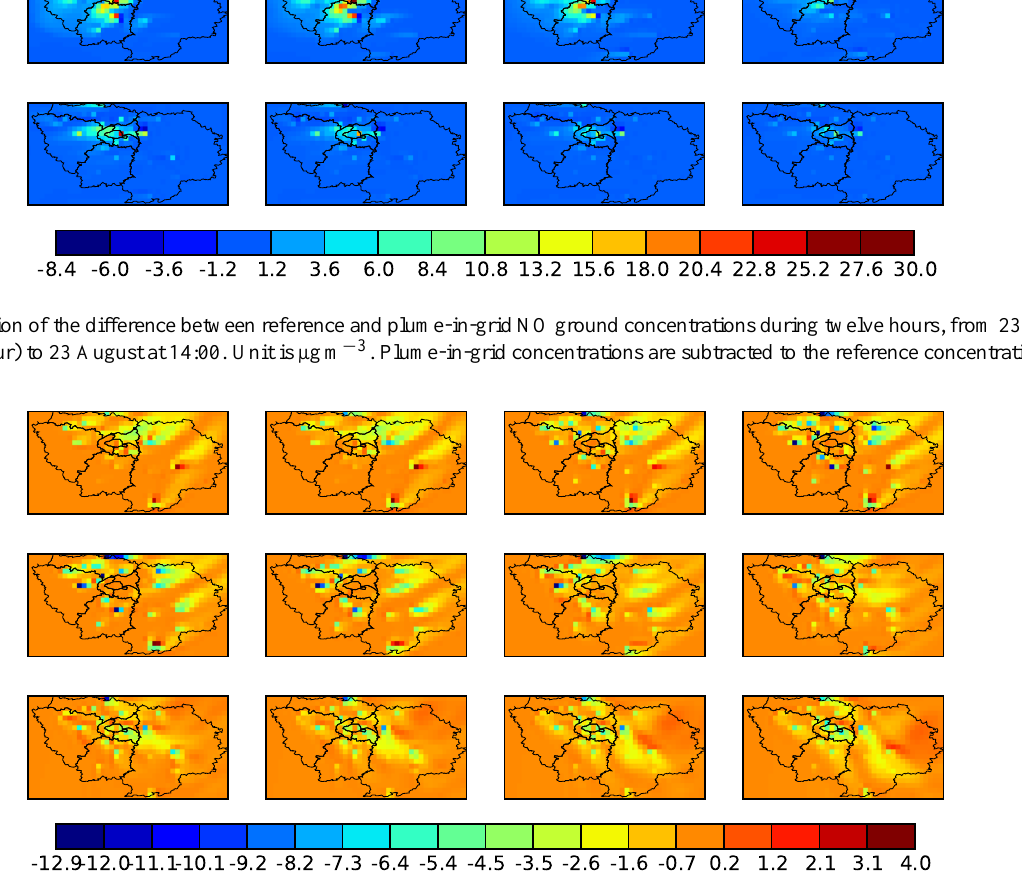
Fig. 11. Evolution of the difference between reference and plume-in-grid O 3 ground concentrations during twelve hours, from 20 August at 03:00 (local hour) to 20 August at 14:00. Unit is µgm − 3 . Plume-in-grid concentrations are subtracted to the reference